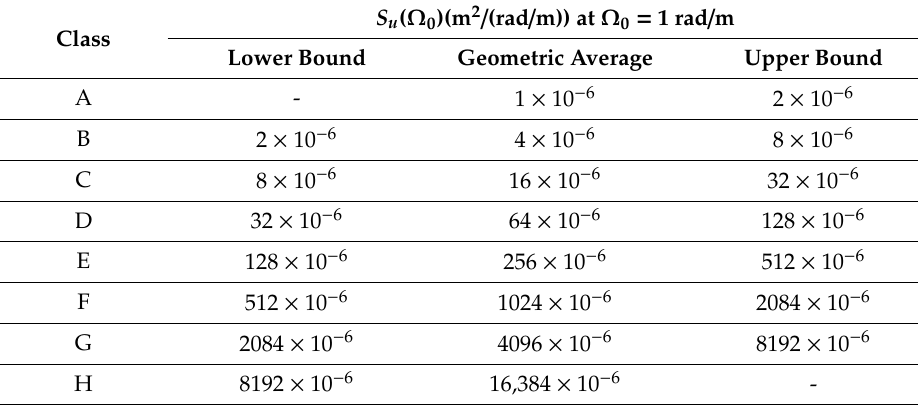
Table 1. Classification of pavements according to Road unevenness